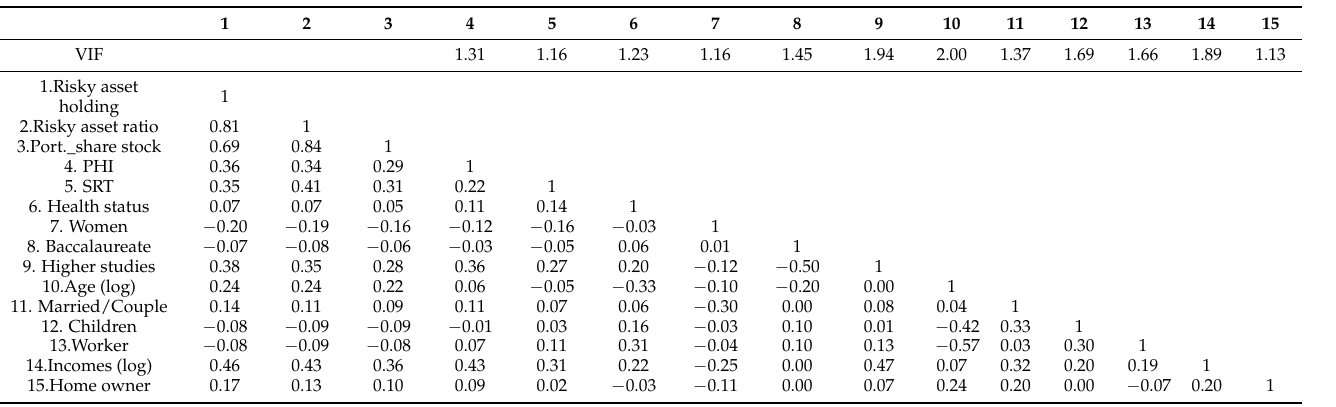
Table A2. Correlations matrix and Variance Inflation Factor (VIF).